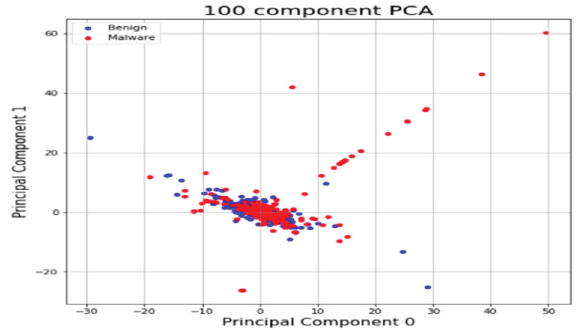
Figure 13. Feature vector distribution of Linux binary.